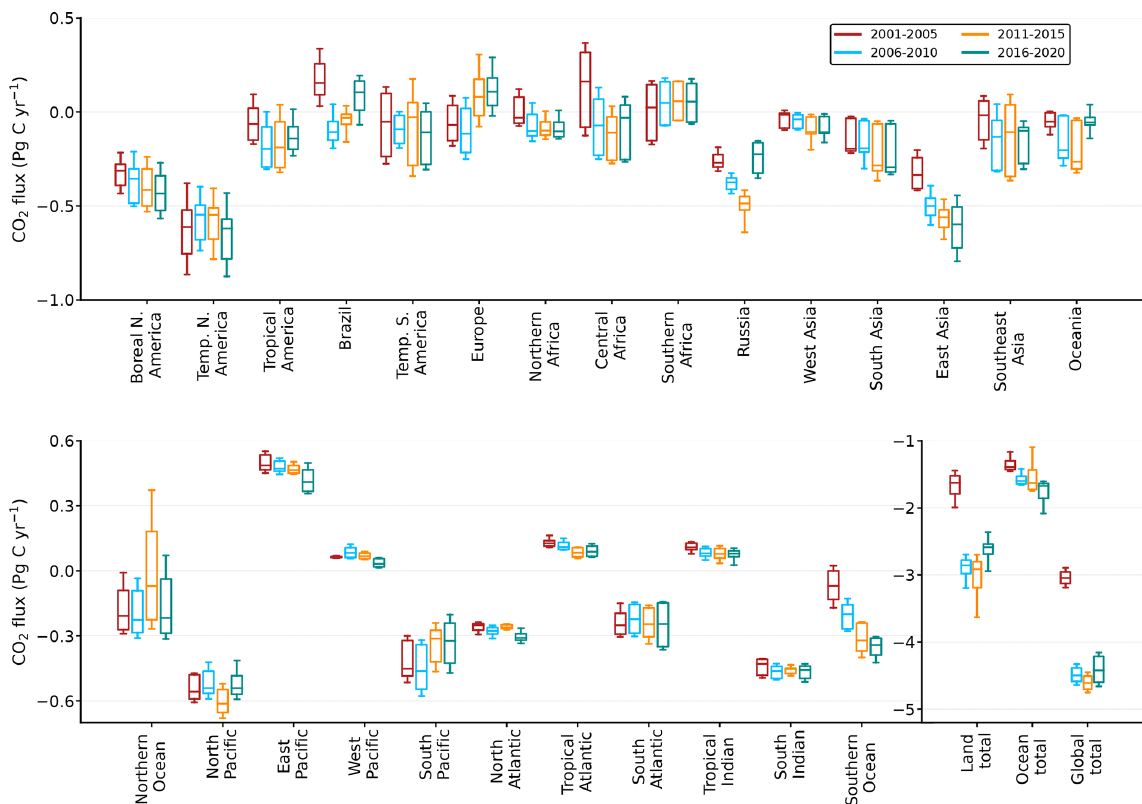
Figure 10. CO 2 fluxes for land and ocean sink using 16 sets of inversion cases. Box plots represent inversions for different time periods. Based on different prior fluxes, PFU, and MDU, the different inversion cases are first averaged for the selected time period. The box shows 25 and 75 percentiles spread, and the vertical line shows 5 and 95 percentiles from the mean CO 2 flux of 16 ensemble inversion cases. Horizontal lines inside box plots denote the median CO 2 flux of 16 inversion ensembles. Mean and spread for the whole study period (2001–2020) are given in Table